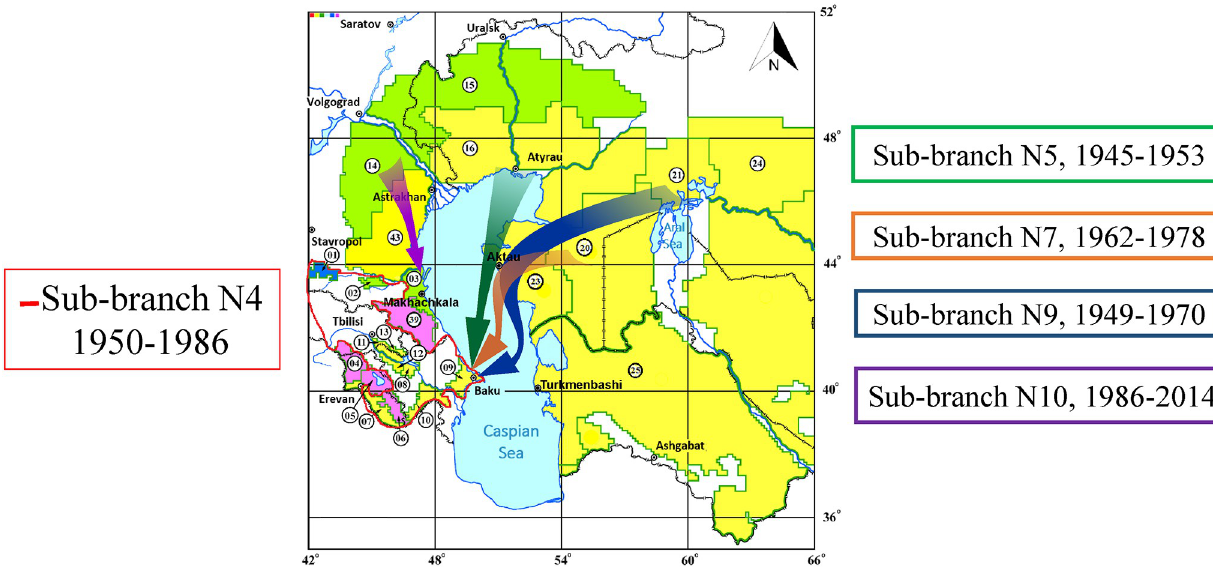
Fig 2. Hypothetical directions of dissemination of the 2.MED1 phylogenetic branch of Yersinia pestis of the medieval biovar in the Caucasus in the 20th-21st centuries. Colored arrows indicate the directions of introduction of the 2.MED branch to the Caucasus. The area of distribution of the Caucasian sub-branch No. 4 of 2.MED1 branch in the foci of the Caucasus is circled with a red line. Green color marks plain and low-mountain foci of the souslik type, yellow–plain and low-mountain foci of the gerbil type, blue–high-mountain foci of the souslik type, pink–high-mountain foci of the vole type. The numbers correspond to the classification of plague foci adopted in Russia and other countries of the Commonwealth of Independent States: 1 –Central- Caucasian high-mountain, 2 –Terek-Sunzha low-mountain, 3 –Dagestan plain-piedmont, 4–6 –Transcaucasian high-mountain (a group of